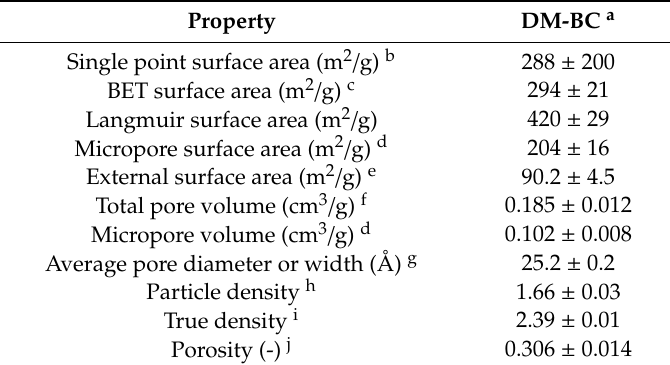
Table 1. Pore properties of resulting biochar